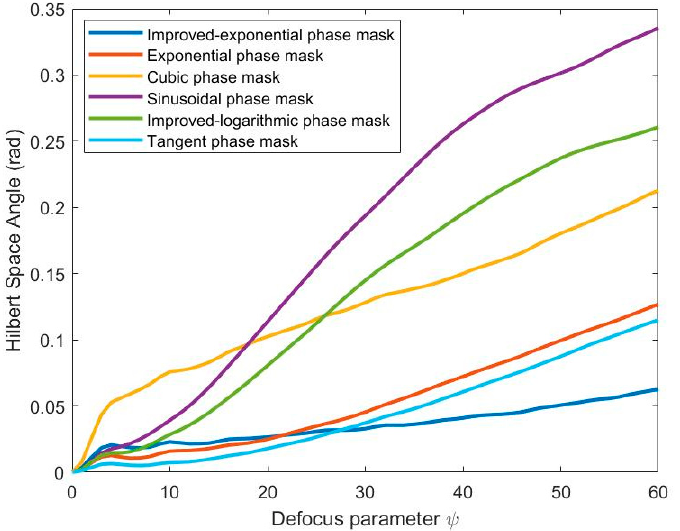
Figure 5. Hilbert space angle of defocus MTF curves of six kinds of phase masks.